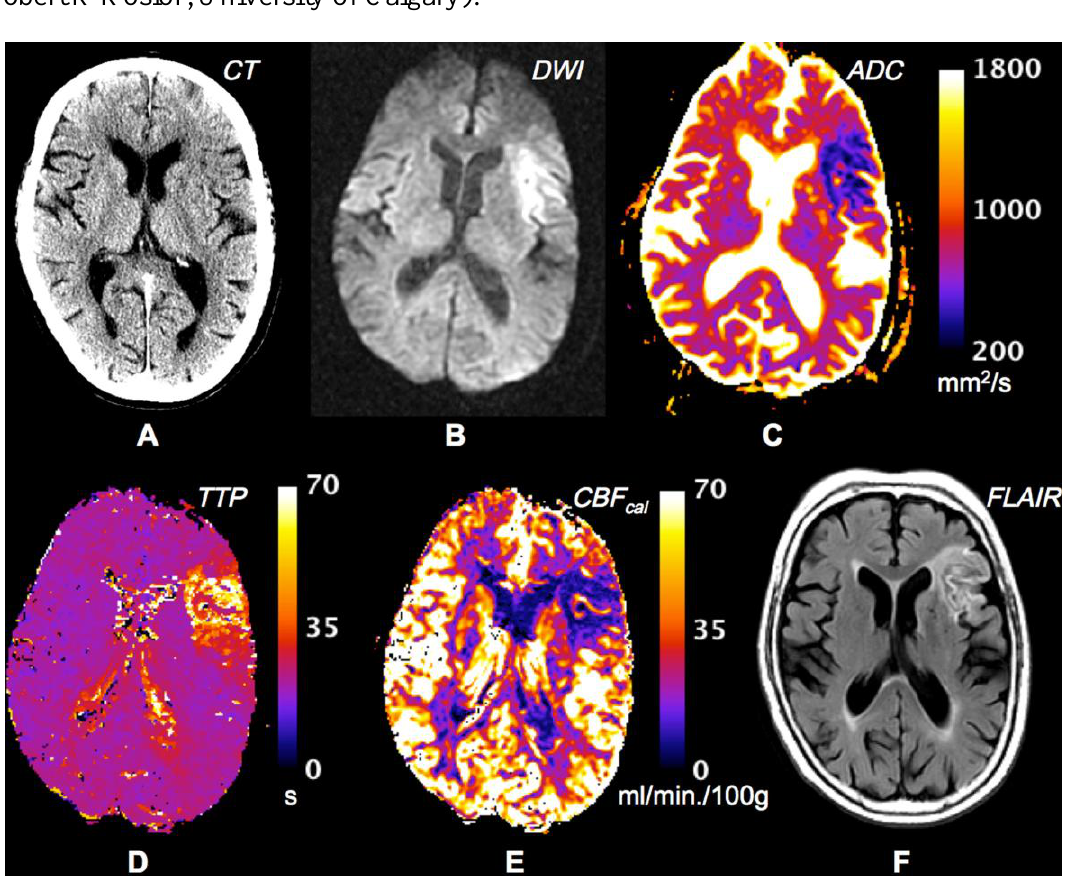
Figure 3. CT and MR imaging for an acute stroke patient (76-year-old female). ( A ) The CT image shows slight hypointensity in the left anterior insular ribbon, as indicated by the yellow arrow. The apparent loss of structural definition suggests ischemia in the middle cerebral artery (MCA) territory. ( B ) DWI image shows very hyperintense areas interpreted as a region of infarction. ( C ) ADC map shows decreased diffusion of water in absolute units within the markedly hyperintense DW region. ( D ) Time-to-peak (TTP) map calculated from a DSC perfusion sequence showing delayed flow to ischemic region. ( E ) Cerebral blood flow (CBF) map computed using deconvolution with an arterial input function as a reference, and then calibrated to white matter in the contralateral side to provide a semi-quantitative depiction of blood flow. ( F ) FLAIR image from day 30 follow-up MR exam shows final infarct to match closely with acute infarct. There was a delay time of 1.2 h from stroke onset to CT imaging, and an additional delay of 2.6 h to MR imaging. The patient was treated with intravenous tPA 1.5 h after onset–before the MR exam. DWI typically depicts infarction with greater lesion contrast as is the case here. The lack of a distinct perfusion-diffusion mismatch and no evident growth on follow- up may be at least partly attributable to recanalization occurring as a result of tPA administration (courtesy of Robert K Kosior, University of